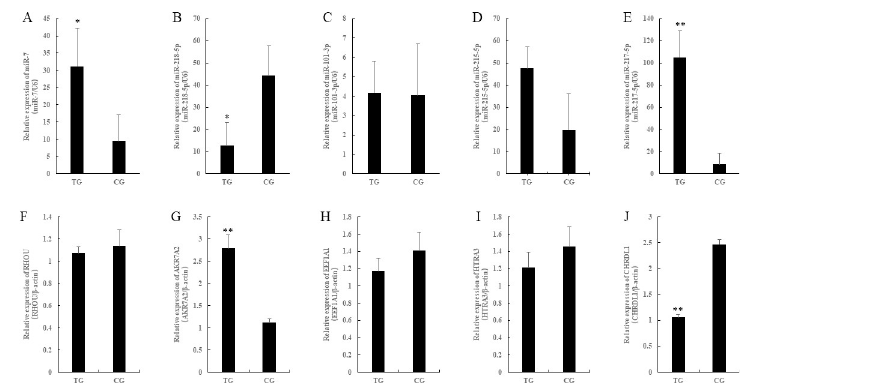
Fig 5. Validation of selected miRNAs and Mrna by qRT-PCR. � Means P < 0.05, �� means P < 0.01.